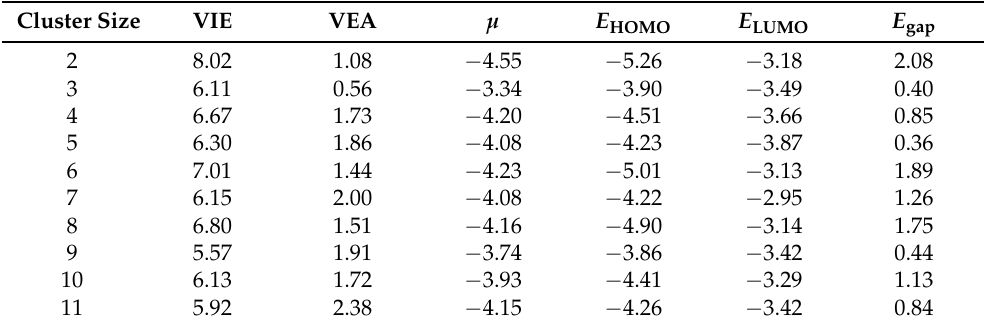
Table 3. Calculated values of VIE, VEA, µ , the energy of HOMO, that of LUMO, and E gap of Ag n ( n = 2–11) clusters. All quantities are given in